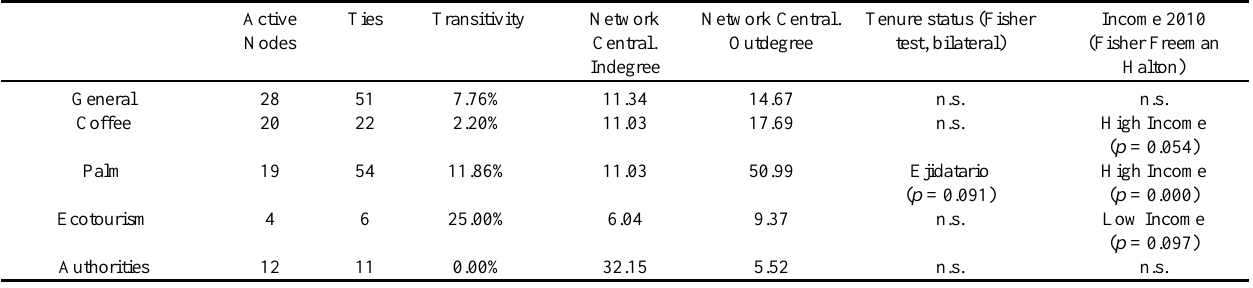
Table 1 . Characteristics of the specific networks; n.s.= not statistically significant.